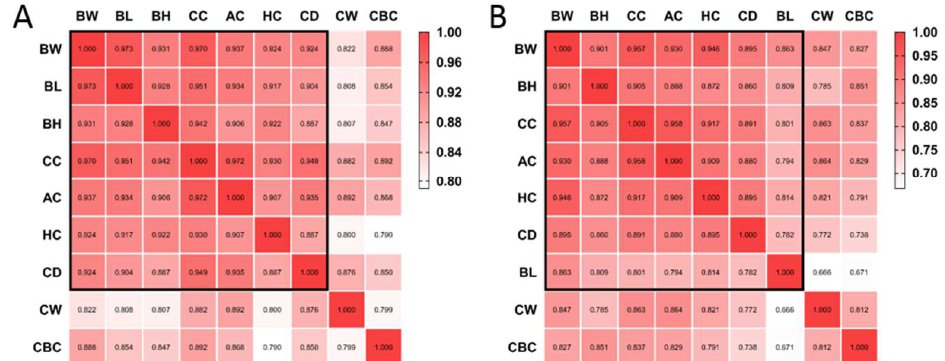
Figure 2. Heatmap of Pearson correlation coefficient matrix. ( A ) Early growth stage (10–60 kg of body weight); ( B ) late growth stage (60–120 kg of body weight). BW—body weight; BL—body length;